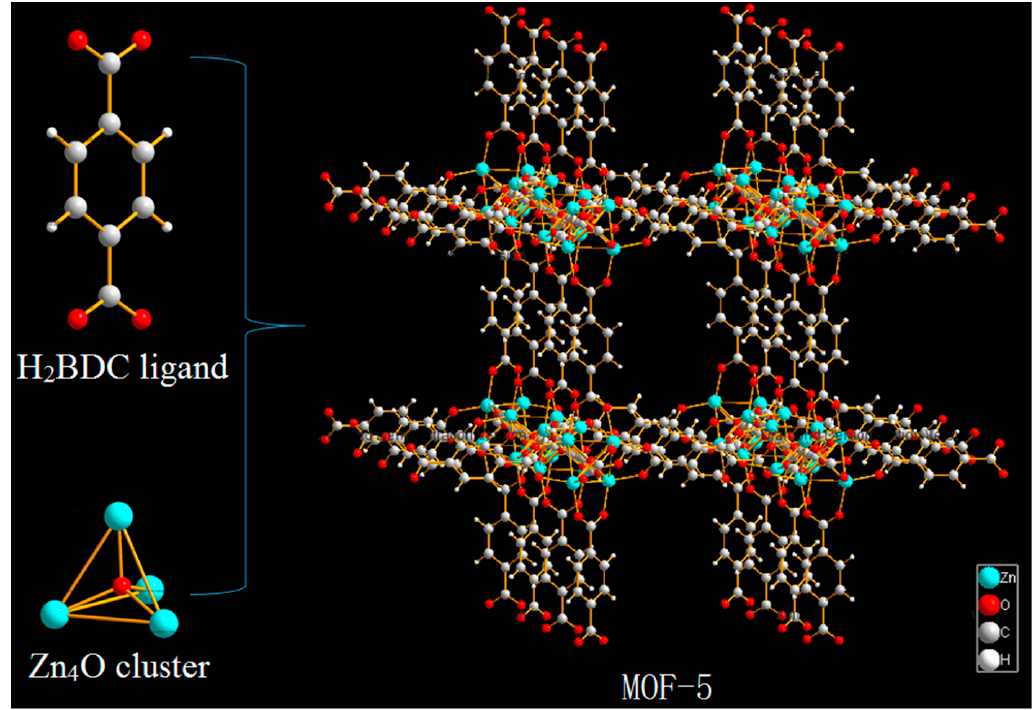
Figure 2. Schematic illustration of the construction of metal organic framework material (MOF-5).